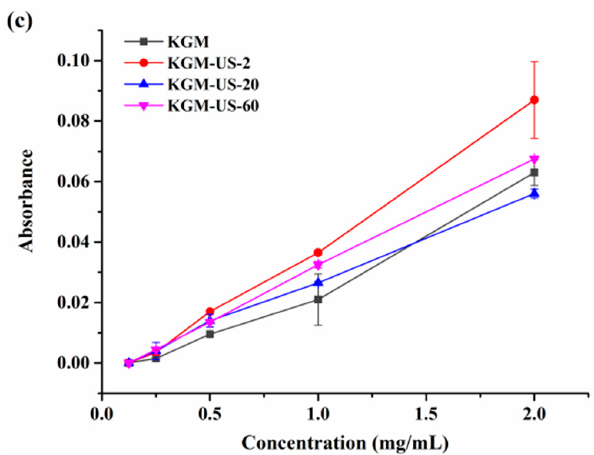
Figure 6. In vitro antioxidant activities of original (KGM) and US-treated KGM (KGM-US-2, KGM-US-20, and KGM-US-60): ( a ) 2,2 ′ -diphenyl-1-picrylhydrazyl (DPPH) radical-scavenging activity; ( b ) 2,2 ′ -azino-bis-3-ethyl-benzothiazoline-6-sulphonate (ABTS) radical scavenging activity; ( c ) ferric-reducing antioxidant power. All values are expressed as means ± SD ( n = 2). Original KGM and US-treated KGM fractions were prepared with distilled water to various concentrations of 0.125, 0.25, 0.5, 1.0, and 2.0 mg/mL.